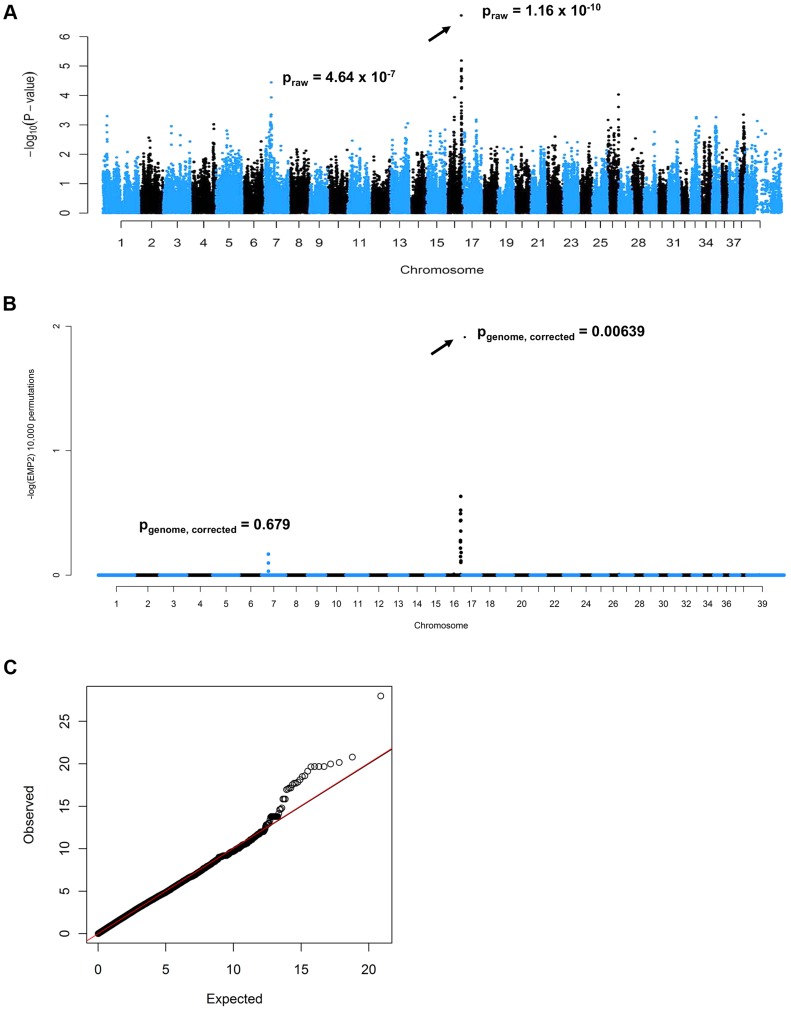
Genome-wide association mapping of Leonberger PN.(A) Manhattan plot of GWAS for PN with 93 (52 cases, 41 controls) Leonbergers. X-axis = chromosome, Y-axis = negative decadic logarithms of permutation-corrected P-values. (B) Manhattan plot of GWAS for PN with 93 Leonbergers. X-axis = chromosome, Y-axis = negative decadic logarithms of permutation-corrected P-values, after correction for population stratification and cryptic relatedness using a mixed model approach and genomic control. (C) The quantile-quantile (QQ) plot corresponding to (B).